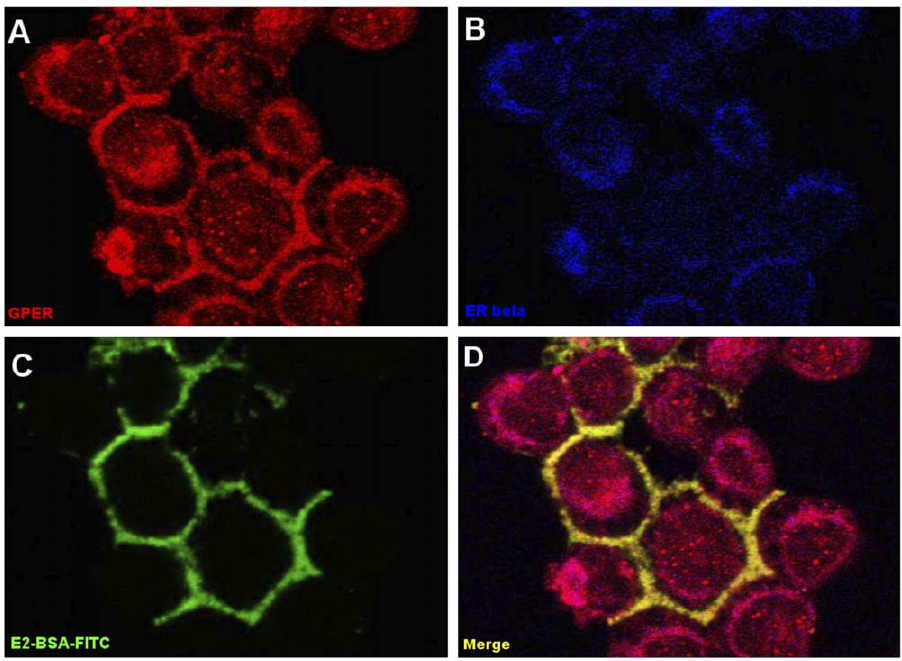
Figure 2. Immunolocalization of GPER in JKT-1 seminoma cells. In JKT-1 cells, GPER (red fluorescence) had both a membranous and intracytoplasmic perinuclear localization (A), whereas the classical oestrogen receptor ER b had an intracytoplasmic perinuclear and nuclear localization (B, blue fluorescence). E2-BSA, an impermeable E2 conjugate that does not cross the membrane, stained the cell membrane when coupled to FITC (C, green fluorescence). By double staining (D), E2-BSA (green) and GPER (red) co-localized at the membrane (yellow [merge]); GPER was also expressed in the cytoplasm (red). (A, B, C, D: magnification, 6 63).